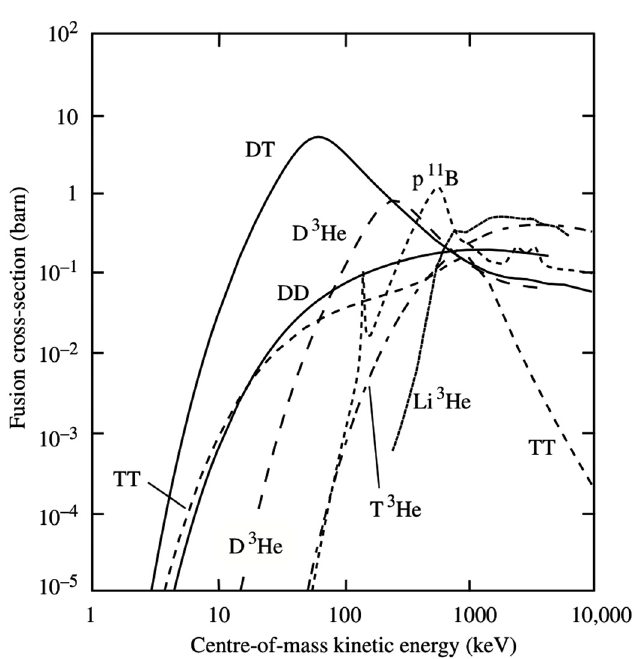
Fig. 3. – Cross-sections (in barn) as a function of the centre-of-mass energies of the reacting particles for various fusion